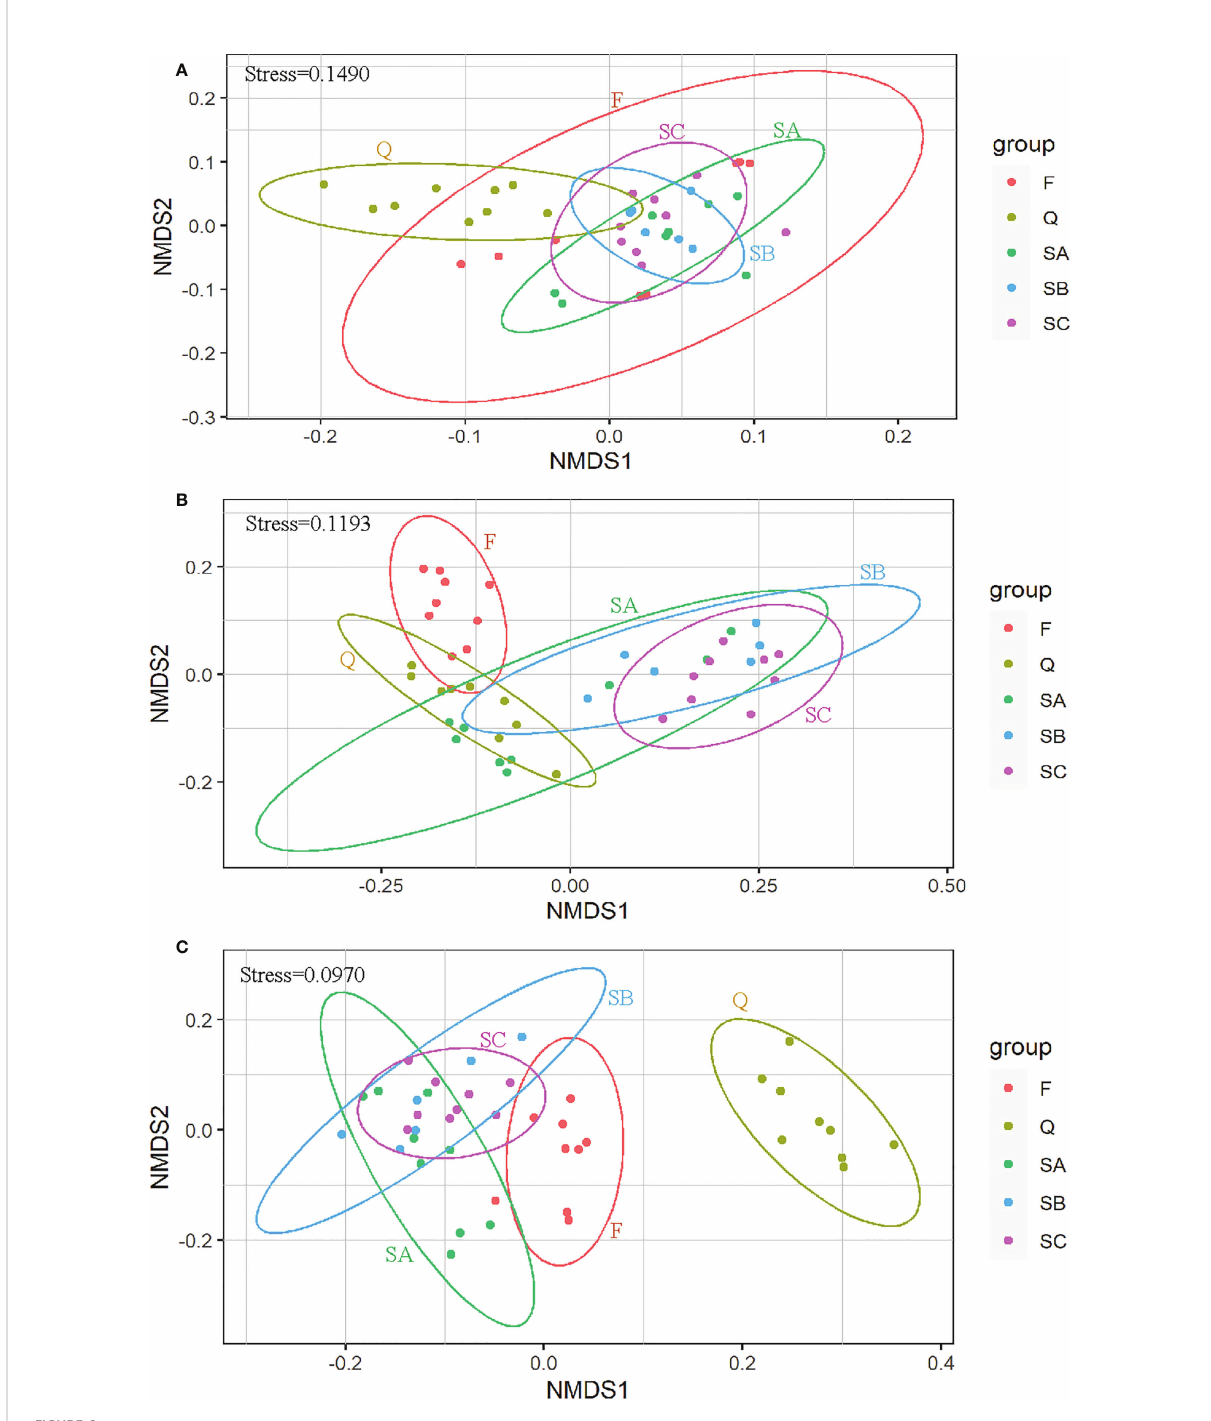
FIGURE 6 Non-metric multidimensional scaling (NMDS) plot depicting Bray – Curtis dissimilarity among these groups in (A) sediment properties including pigments, (B) microbial abundance, and (C) EPS